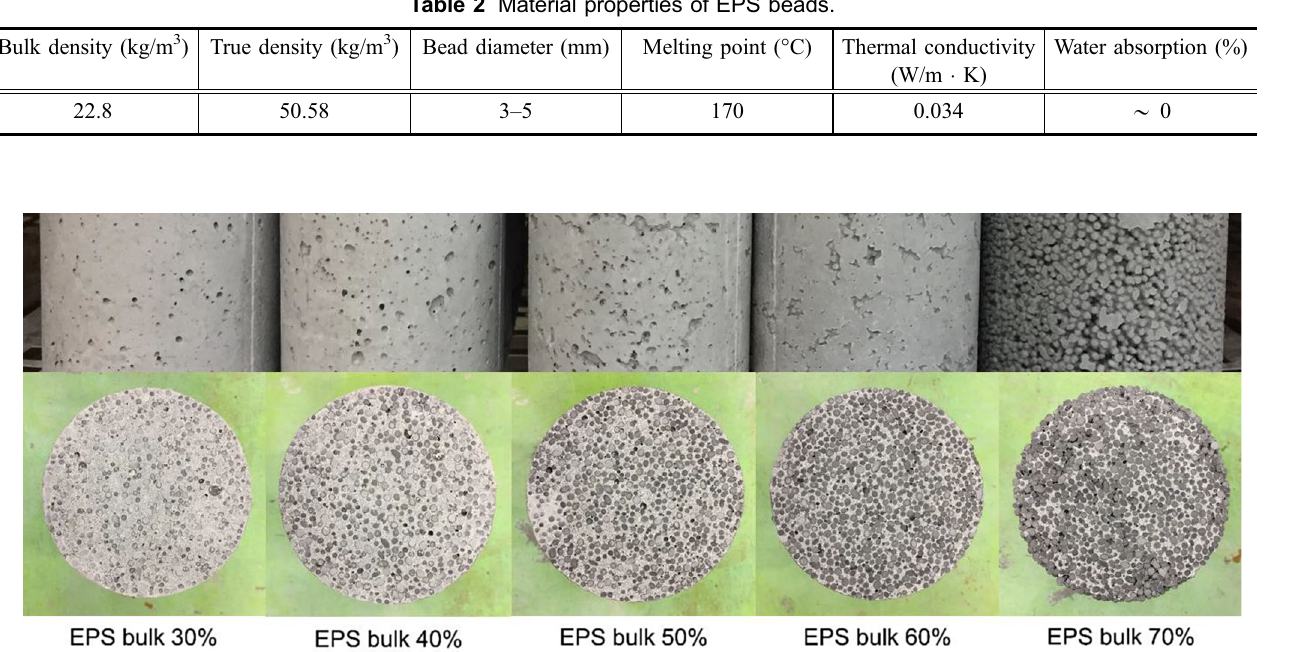
Fig. 2 Side and section views of HPEPC cylindrical specimens with different EPS bulk ratios.